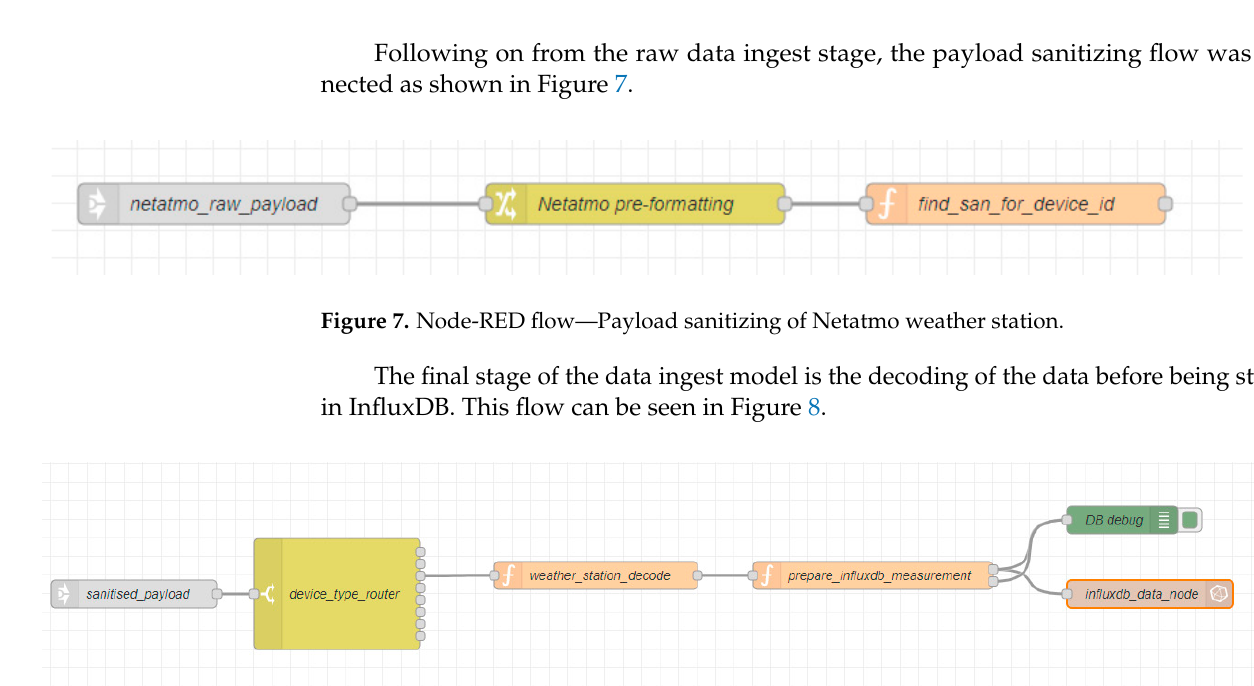
Figure 6. Node-RED flow—Raw data ingest of the Netatmo weather station.